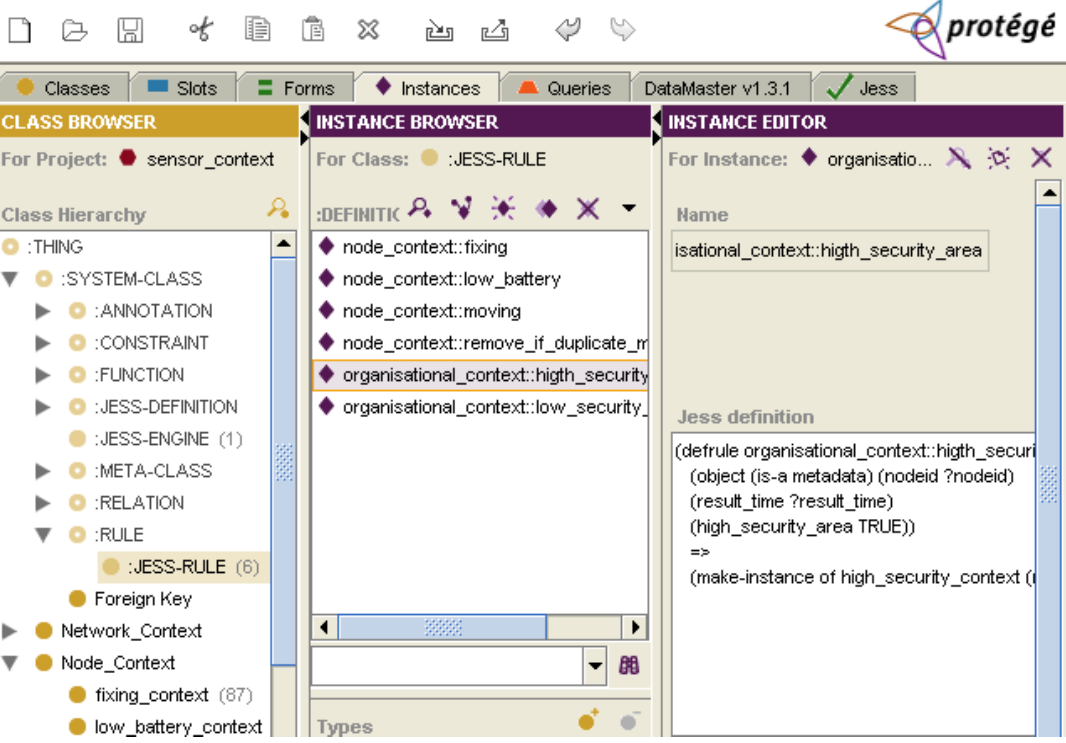
Figure 3. Contextualising rules implemented with Jess in